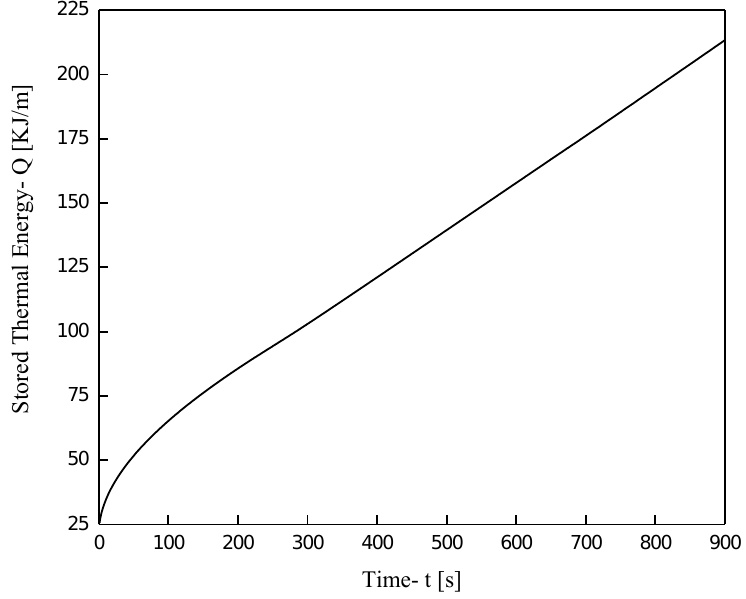
Figure 15. Stored energy variation up to t = 900 s.